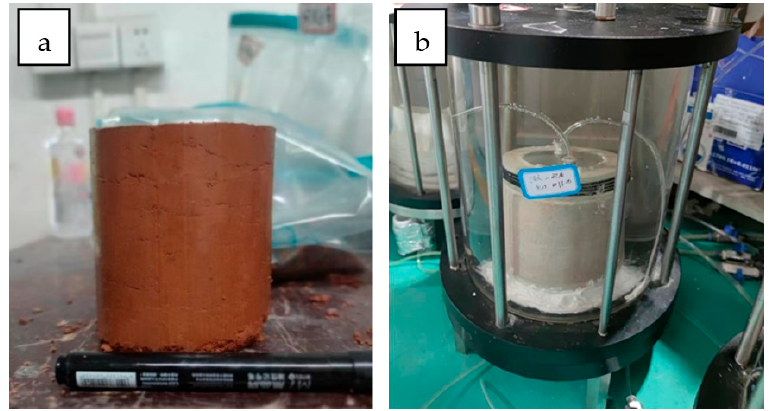
Figure 1. ( a ) Test sample preparation and ( b ) dynamic adsorption test setup.